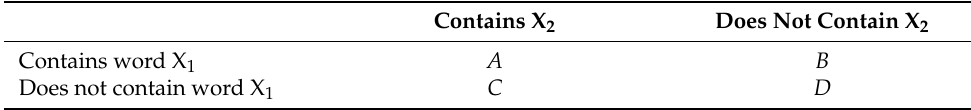
Table 1. Frequencies of the two words within each line. Contains X 2 Does Not Contain X 2 Contains word X 1 A B Does not contain word X 1 C